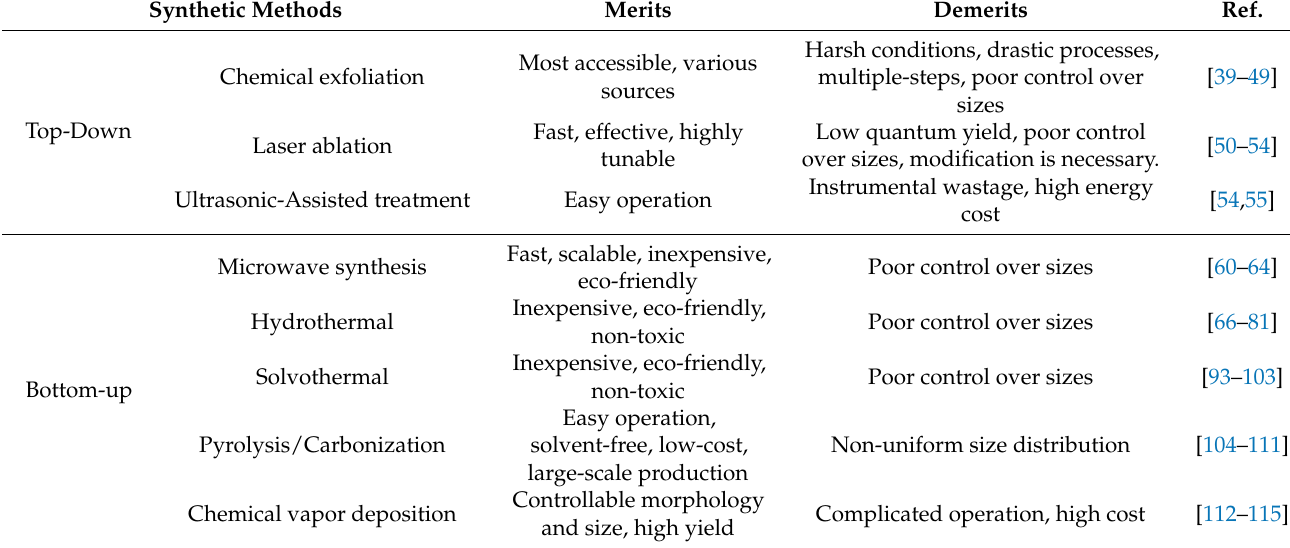
Table 2. Comparison of the merits and demerits of representative